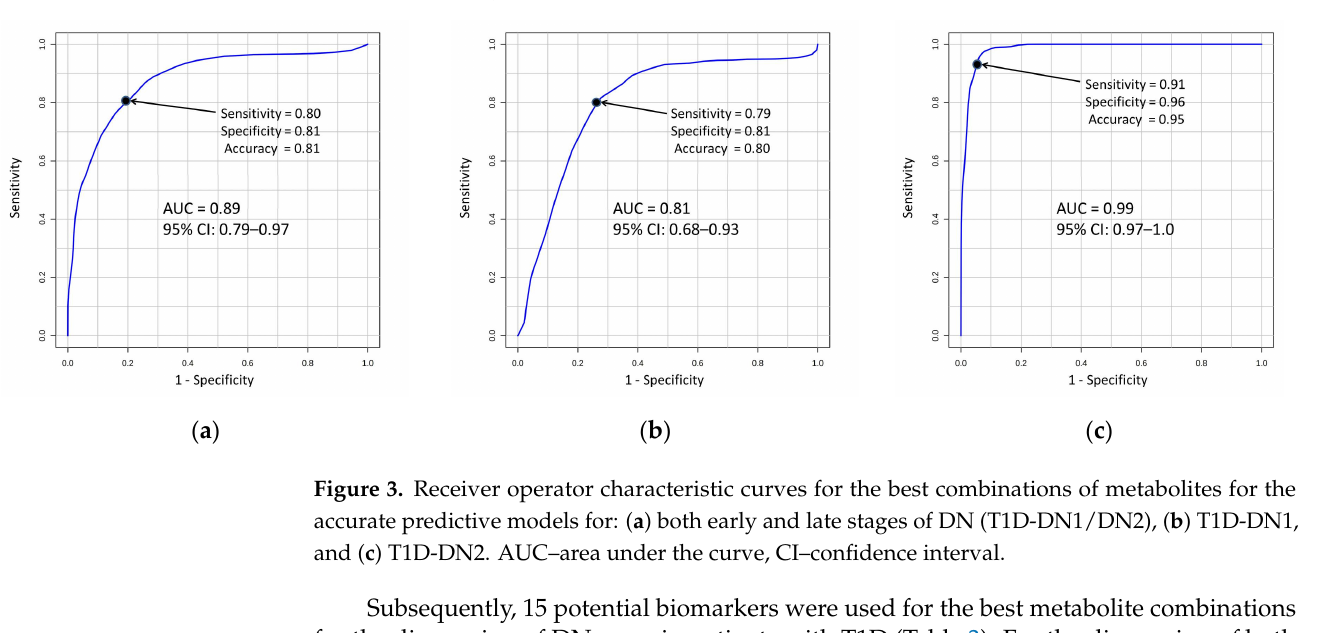
creatine, 1 ‐ methylhistidine, L ‐ arginine, citrulline, oxalosuccinic acid, N ‐ acetyl ‐ b ‐ glucosaminylamine, N2 ‐ succinyl ‐ L ‐ ornithine, and 3 ‐ carboxy ‐ 4 ‐ methyl ‐ 5 ‐ propyl ‐ 2 ‐ furanpropionic acid) with the area under the curve